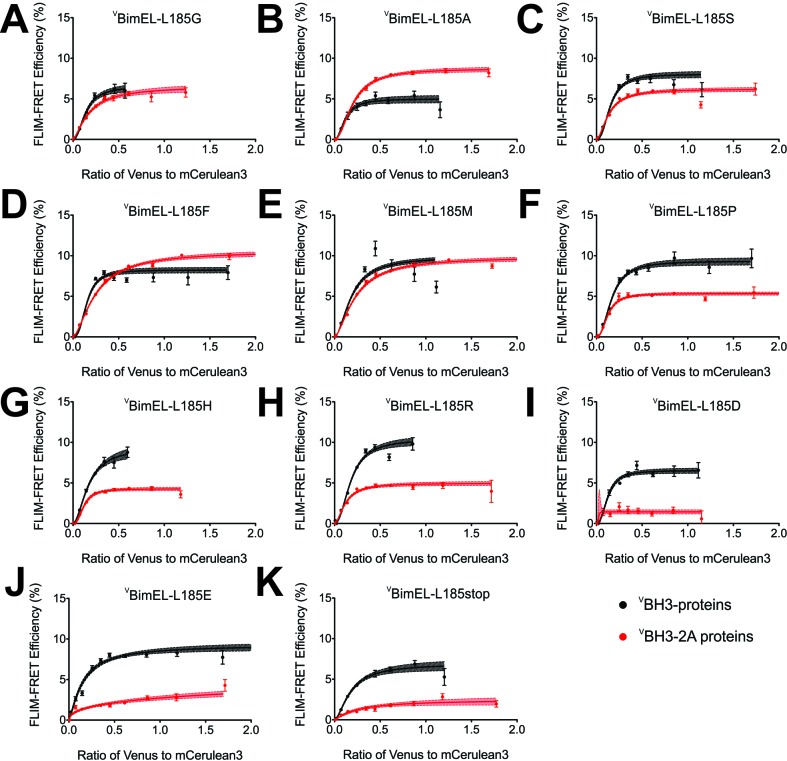
The Bim CTS adopts a non-conventional conformation that allows binding to both membranes and Bcl-XL through hydrophobic interactions.(A–K) FLIM-FRET binding curves for VBimEL (black) and VBimEL-BH3-2A (red) with the indicated amino acid substitutions for L185 indicate that non-charged amino acids are preferred for binding to CBcl-XL. Substitutions that negatively impact VBimEL-BH3-2A binding to CBcl-XL result in red curves with lower FLIM-FRET efficiencies than the ones obtained for VBimEL (black). The substitution L185A increased VBimEL-BH3-2A binding back to approximately the same as VBimEL WT (red line above black curve). Substitutions with other uncharged amino acids had little impact however, substitution with charged residues dramatically reduced binding of VBim-BH3-2A to CBcl-XL on membranes (compare panels A-E with F-K). Error bars, SEM; (20 < cells/bin < 3,000); shadowed area, 95% confidence interval for the best fit of the model to the data.10.7554/eLife.37689.038Figure 9—figure supplement 2—source data 1.Source data fitted to a Hill equation for the mutants illustrating that the Bim-CTS binds both to membranes and to Bcl-XL.